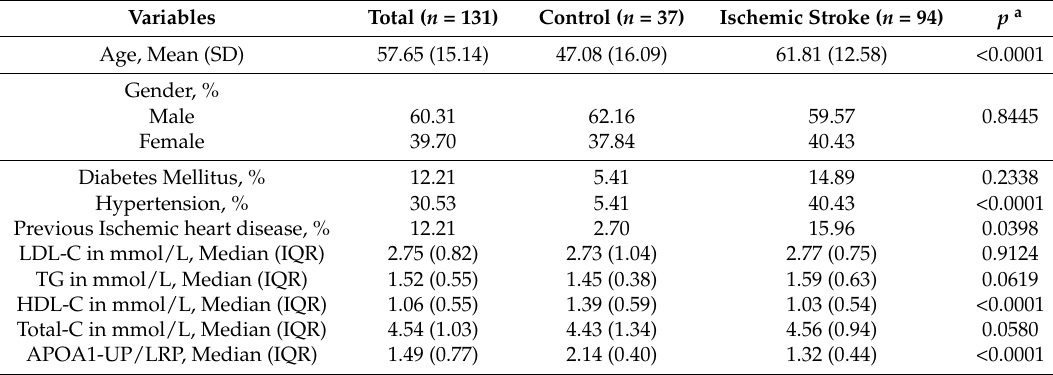
Table 1. Demographic characteristics and clinical variables of the study population.